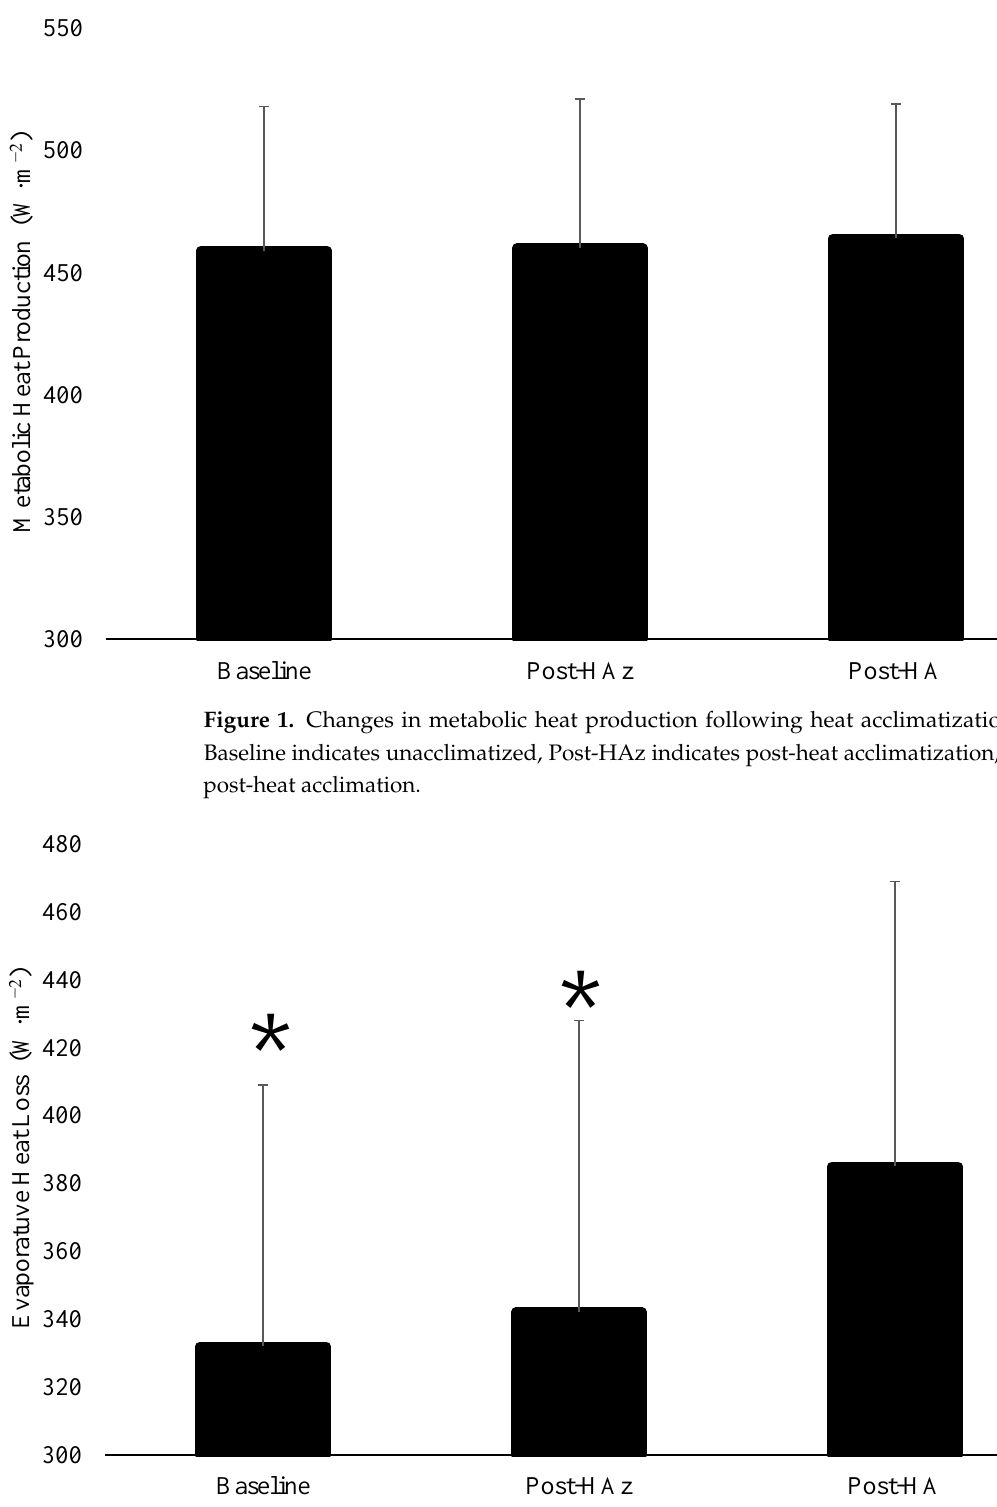
Figure 2. Changes in evaporative heat loss following heat acclimatization and acclimation. * indicates statistical significance following heat acclimation (Post-HA), p ≤ 0.05. Baseline indicates unacclimatized, Post-HAz indicates post-heat acclimatization, Post-HA indicated post-heat acclimation.